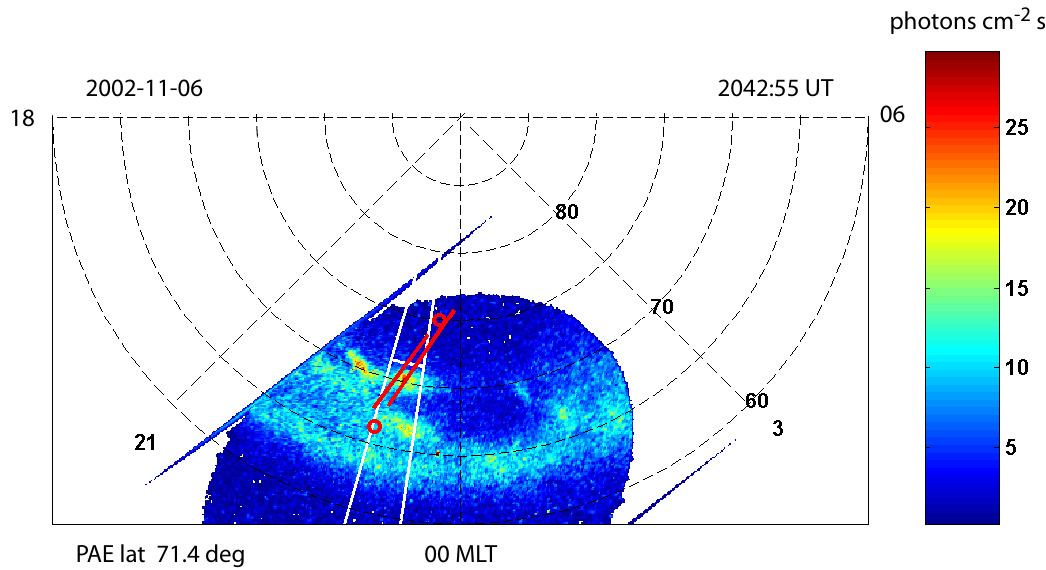
Fig. 4. Polar UVI taken at 20:42:55 UT in geomagnetic coordinates. The MLT zone used in calculating PAE is shown by white lines as well as the calculated PAE. The ESR 32m and VHF beam projections are shown in the figure.